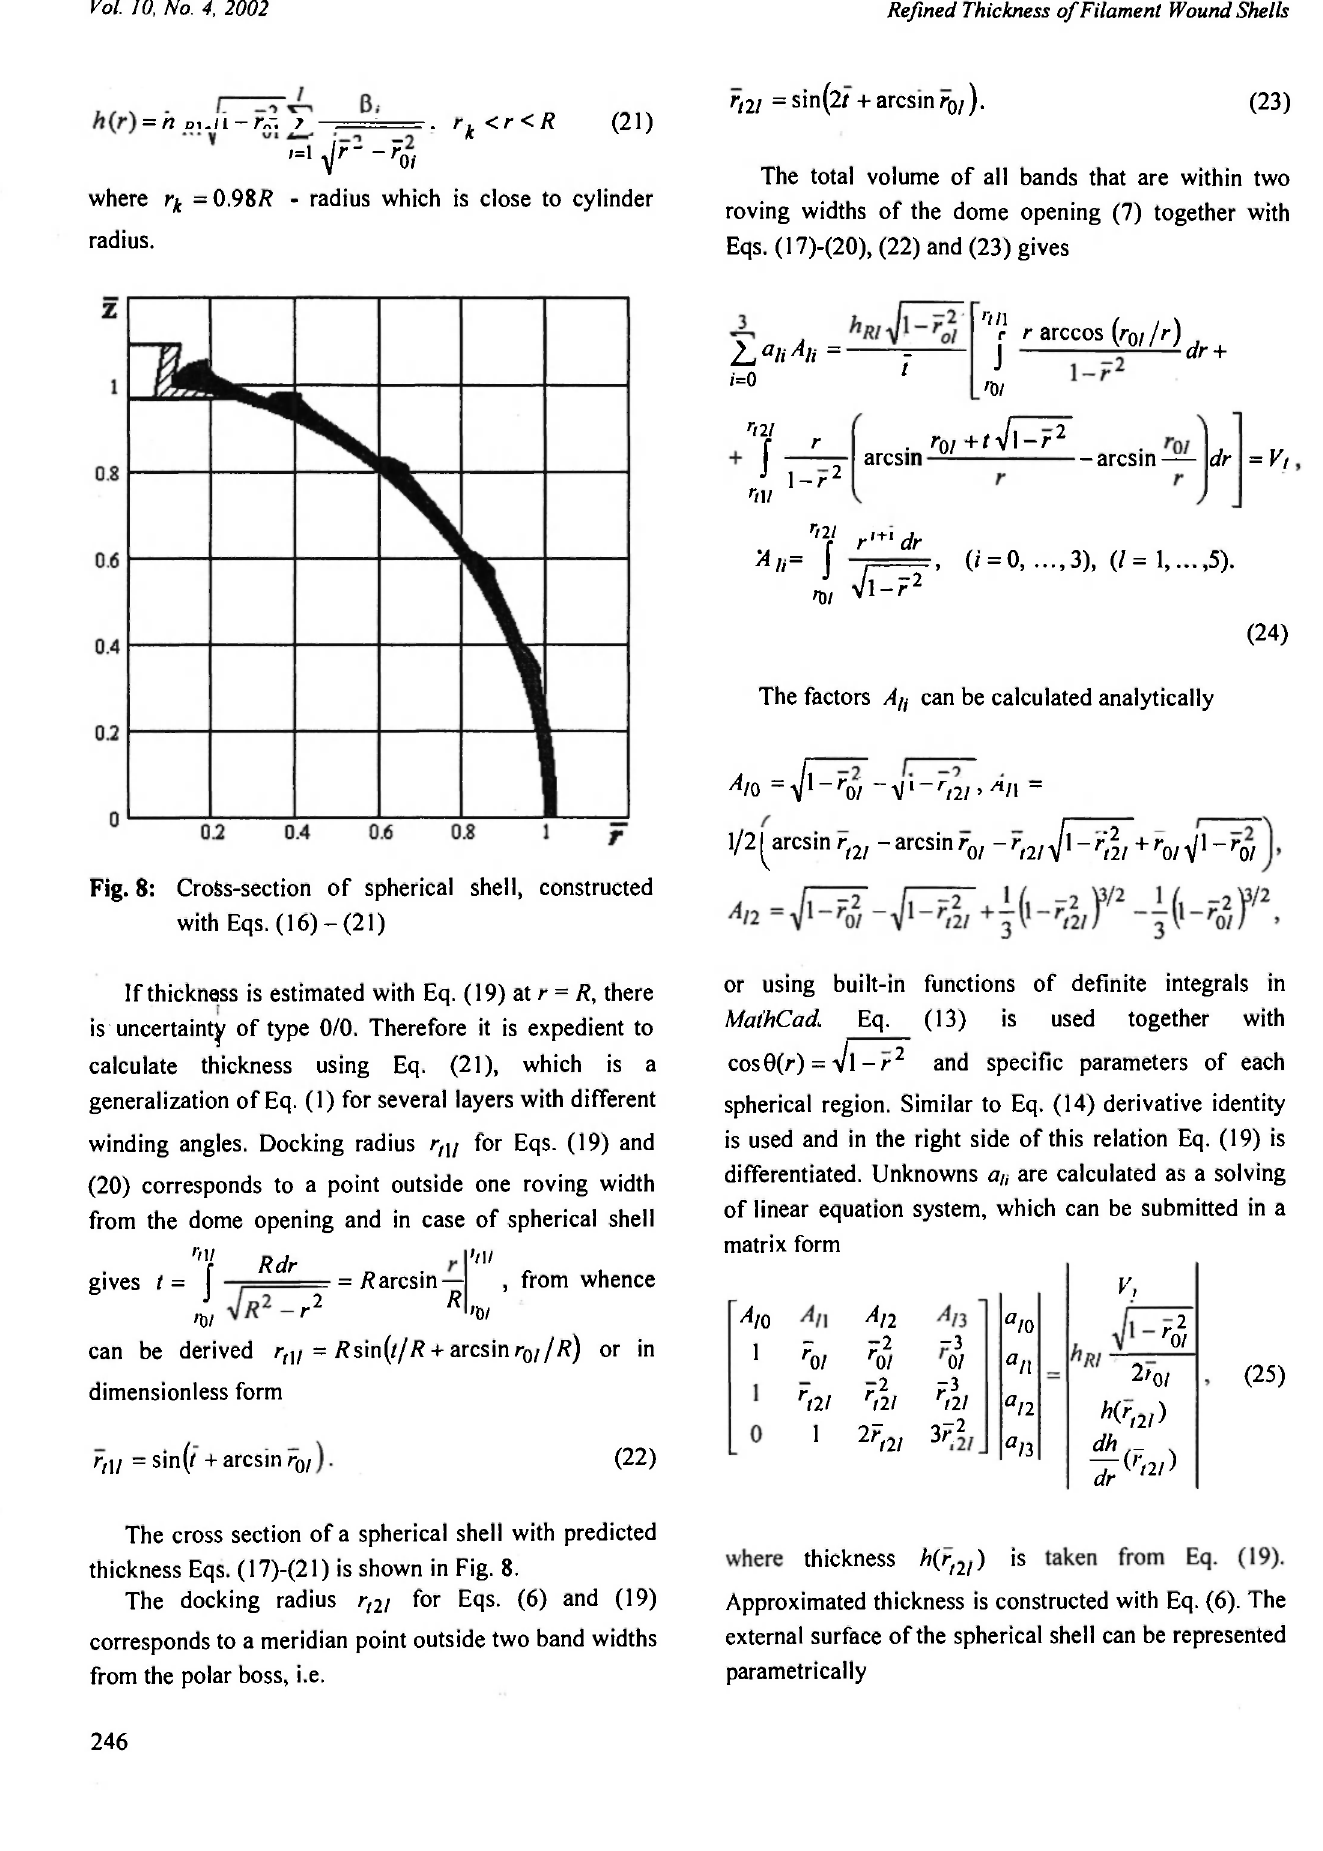
The cross section of a spherical shell with predicted thickness Eqs. (17)-(21) is shown in Fig. 8. corresponds to a meridian point outside two band widths from the polar boss,